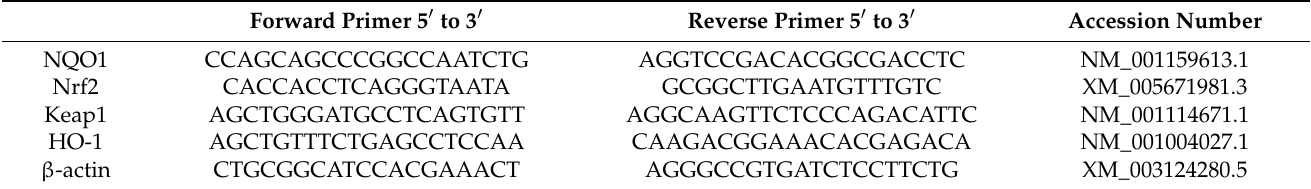
Table 2. Primer sequences 1